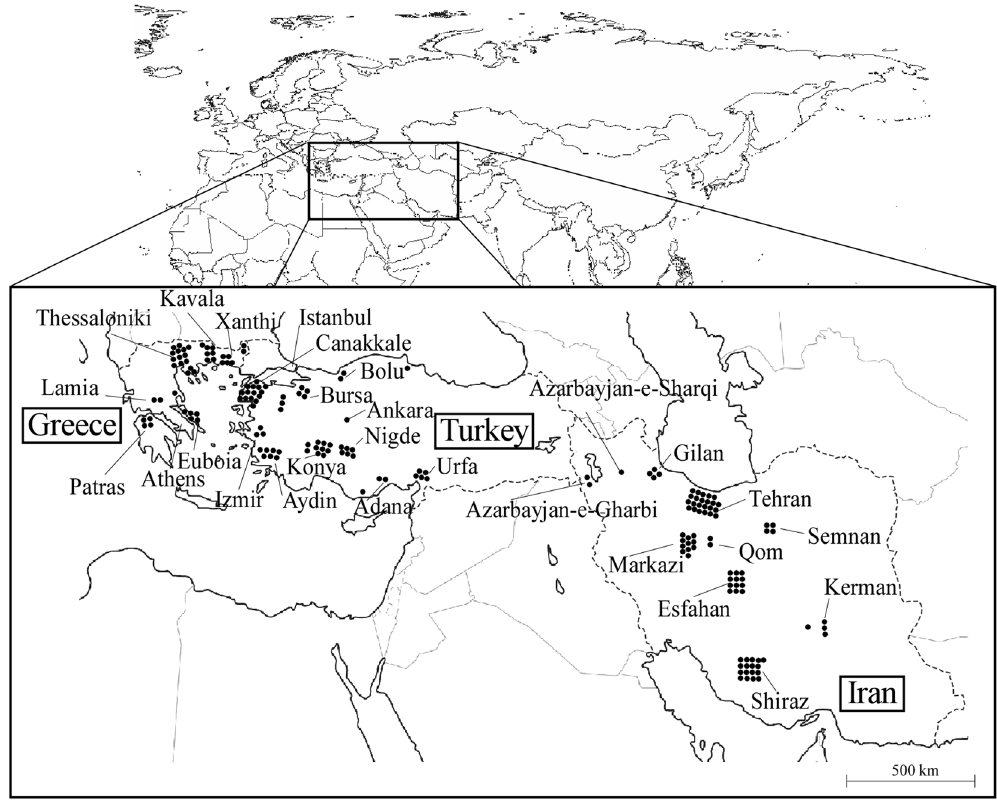
Figure 1. Map showing the provenance of the turnip mosaic virus isolates from Greece, Turkey and Iran. Dots on the map correspond to the isolates listed in Supplementary Table S1 (http://www.freemap.jp/about_use_